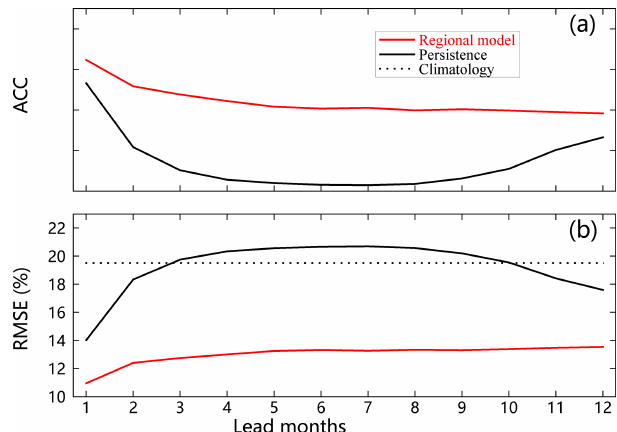
Figure 6. Cross-validated model skills measured by ACC between SIC predictions and observation anomalies as a function of seasons and lead months. Only the correlations that are significantly above the 95% confidence level based on Student’s t test are included in the panels.